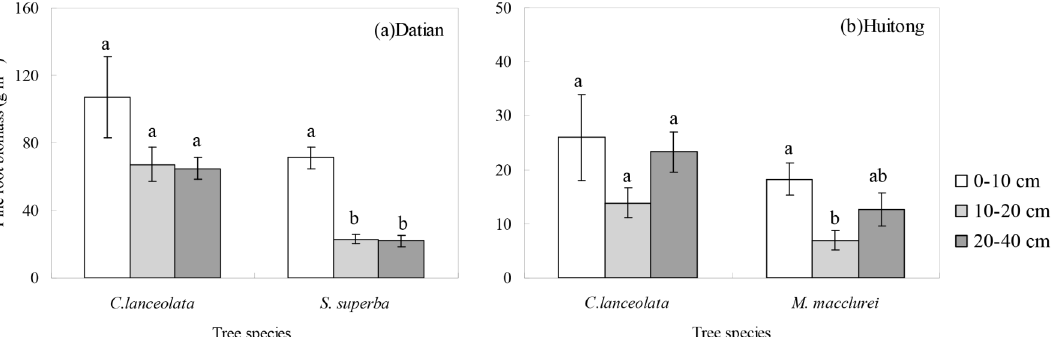
Fig 2. The FRBs of (a) C . lanceolata and S . superba in D-Mixed at Datian and (b) C . lanceolata and M . macclurei in H-Mixed at Huitong along the soil profile for five plot replicates per stand and nine sampling locations per plot. Error bar represents one standard error of the mean. Different letters indicate significant differences among soil depths ((a) S . superba : F = 11.260, P = 0.002; (b) M . macclurei : F = 4.536, P = 0.034).